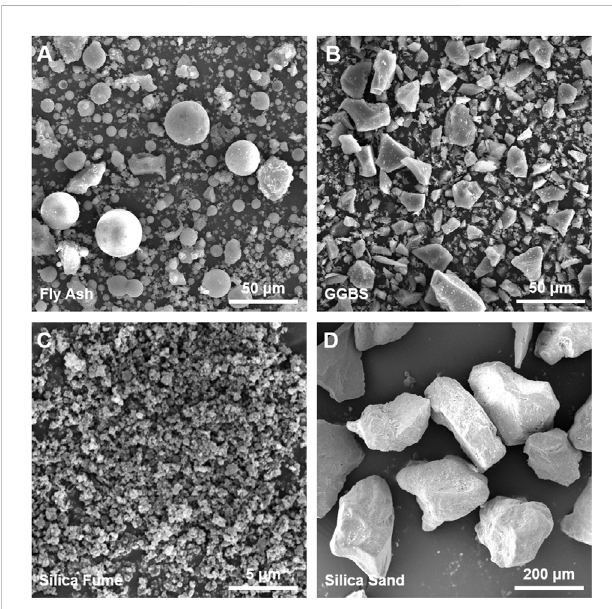
FIGURE 1 SEM images of raw materials: (A) Fly ash, (B) GGBS, (C) silica fume, and (D) silica sand.